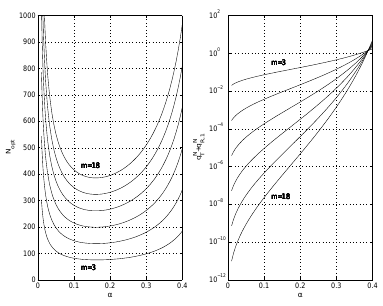
Figure 5. Cross-sections of q T ( α,N,m ) N + q R, 1 ( α,N,m,r 0 ) N for N = 400 , r 0 = 0 . 1 and m = 3 , 6 , 9 , 12 , 15 and 18 .